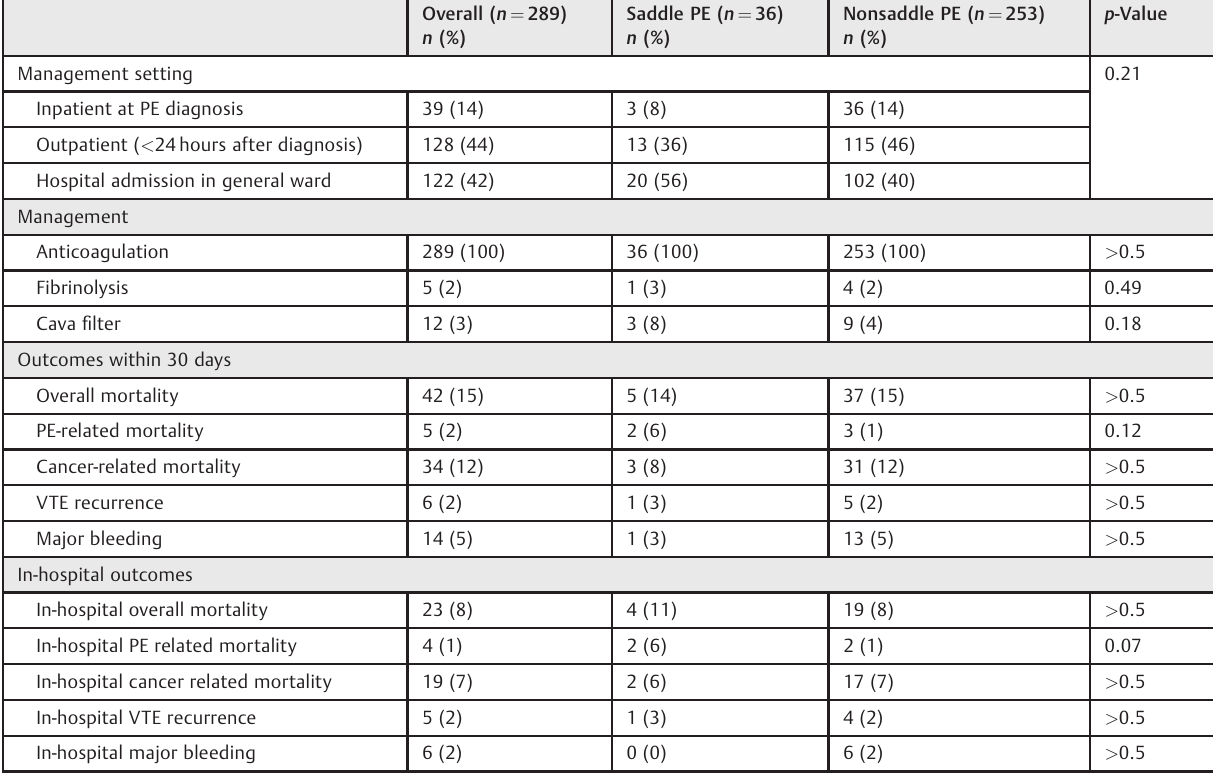
Table 2 Management of patients and 30-day outcomes according to the presence of saddle versus nonsaddle pulmonary embolism